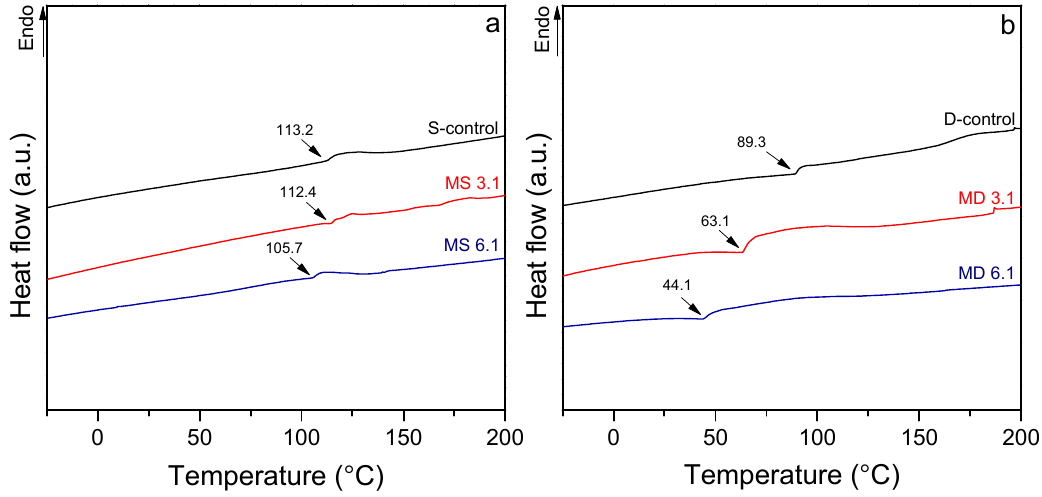
Figure 4. Differential scanning calorimetry (DSC) thermographs of S-control, MS 3.1 and MS 6.1 ( a ) and D-control, MD 3.1 and MD 6.1 ( b ).